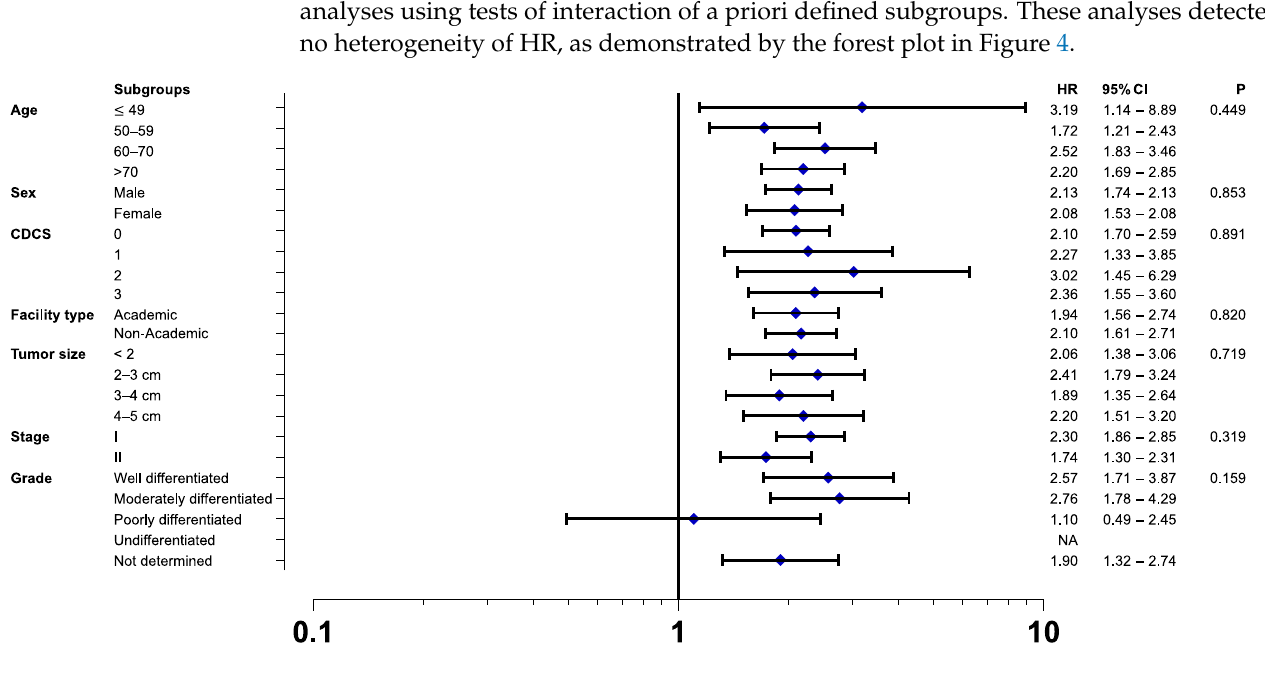
Figure 4. Forest plot depicting the hazard ratio of stereotactic body radiation therapy (SBRT) versus hepatectomy in the matched study cohort. Black squares represent hazard ratios (and 95% confidence intervals are represented by the corresponding horizontal lines).